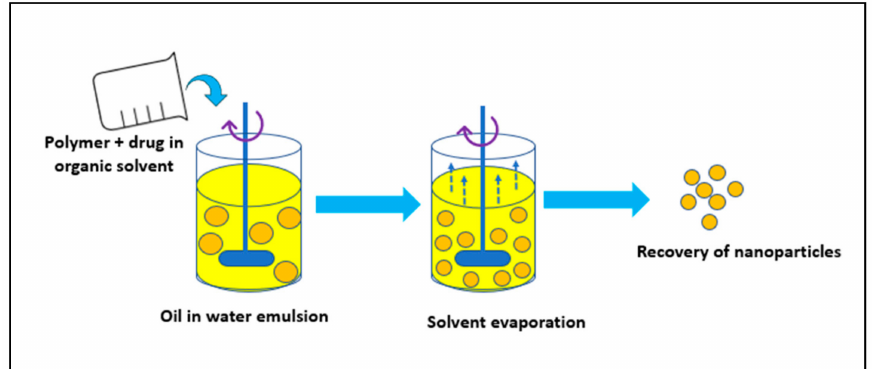
Figure 4. Solvent evaporation